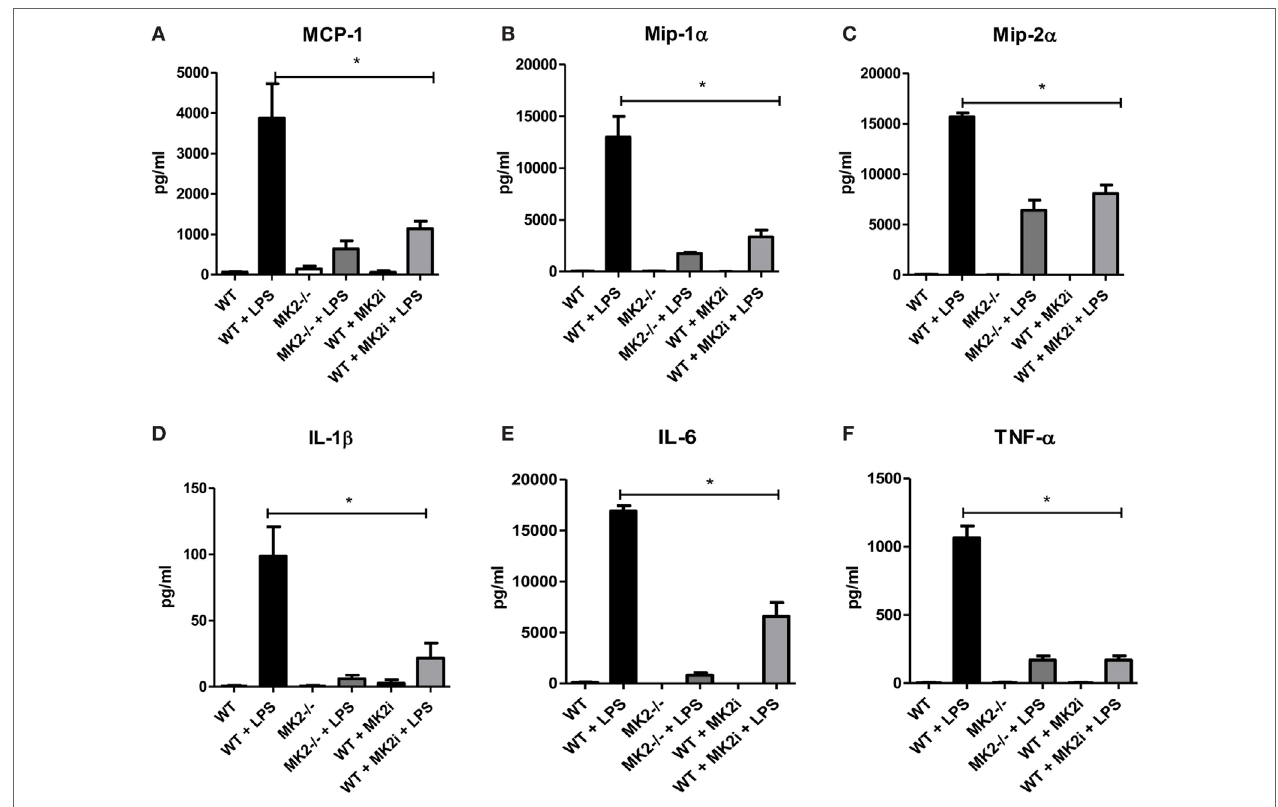
FigUre 5 | The MK2 pathway is critical for macrophage cytokine/chemokine production. Bone marrow-derived macrophages in culture were exposed to LPS for 24 h and cytokine production compared between WT, MK2 − / − , and MK2 inhibitor-treated macrophages by multiplex cytokine array. WT macrophages showed increased production of (a) MCP-1, (B) Mip-1 α , (c) Mip-2 α , (D) IL-1 β , (e) IL-6, and (F) TNF- α while MK2 − / − and MK2 inhibitor-treated macrophages had significantly decreased production. N = 8 from multiple experiments, * p ≤